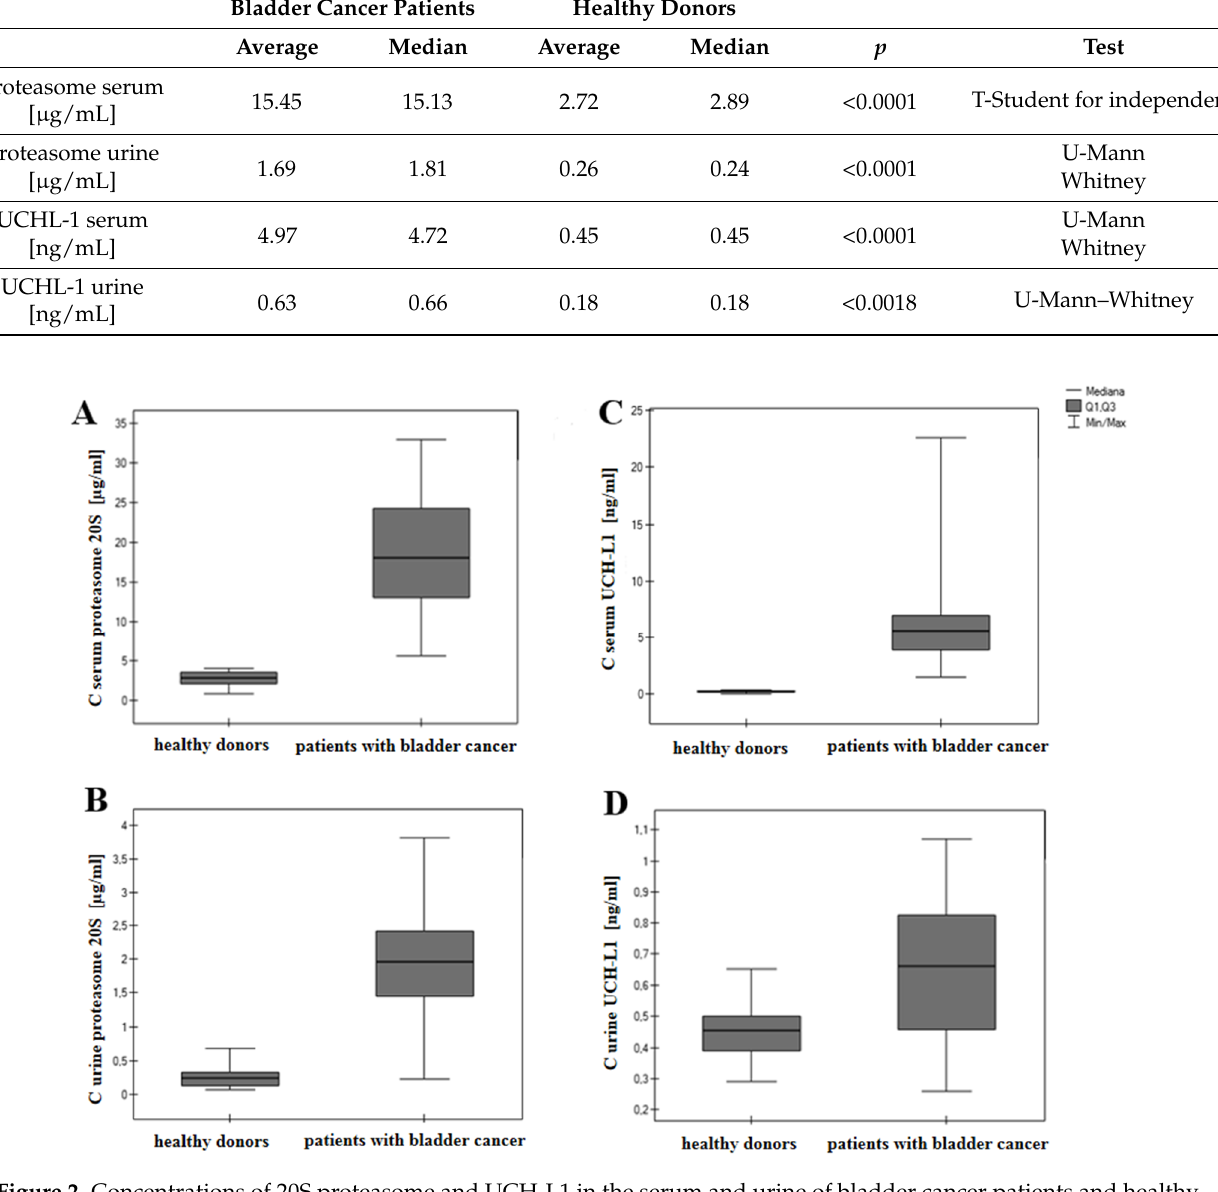
Figure 2. Concentrations of 20S proteasome and UCH-L1 in the serum and urine of bladder cancer patients and healthy subjects. ( A ) and ( C ) in serum samples and ( B ) and ( D ) in urine samples.